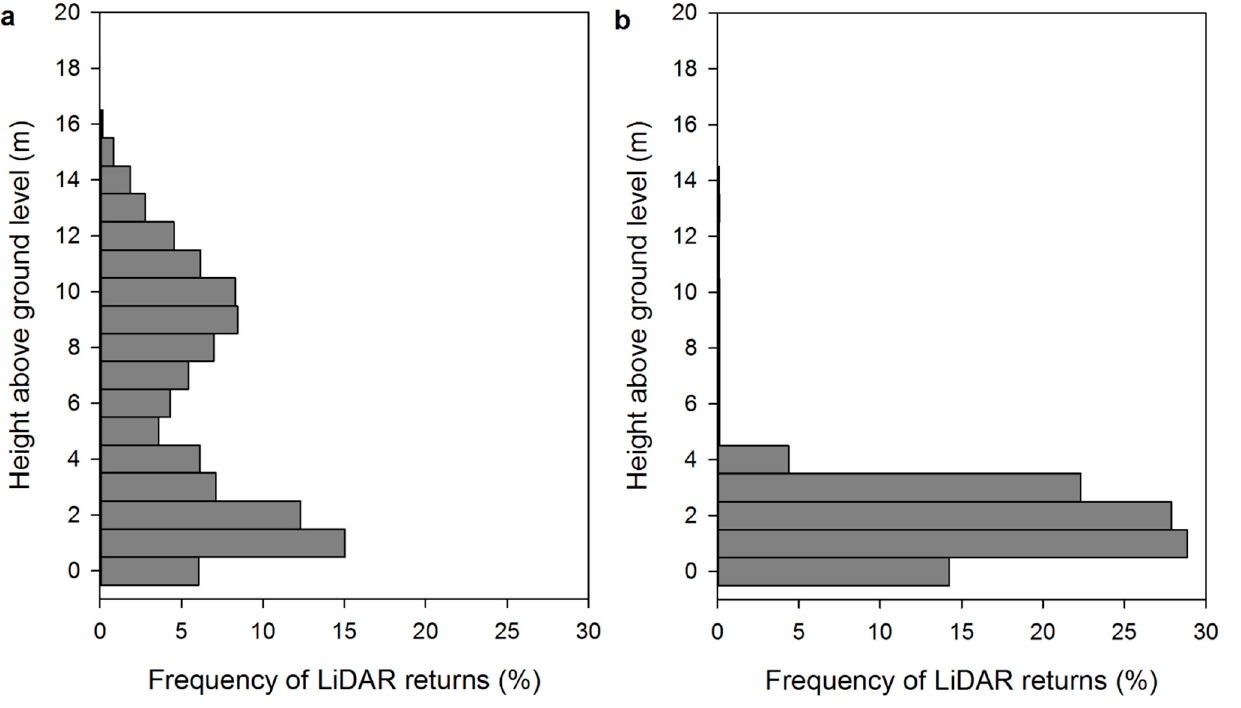
Figure 7. Canopy height profiles of vegetation growing within zones identified as containing ( a ) low A. gayanus canopy cover (0%–20%), and ( b ) high A. gayanus canopy cover